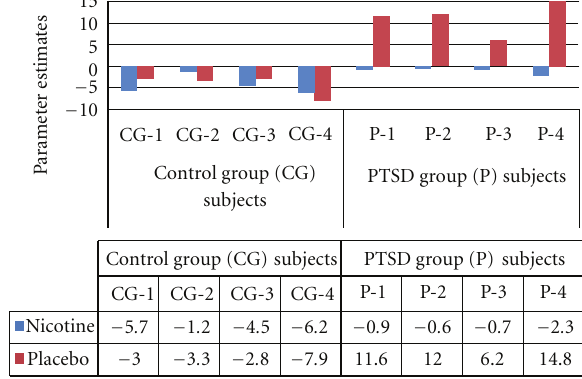
Figure 5: Model parameter estimates of the group x patch interaction on task-related right superior frontal gyrus (SFG) ( x = 24, y = 22, z = 60) BOLD